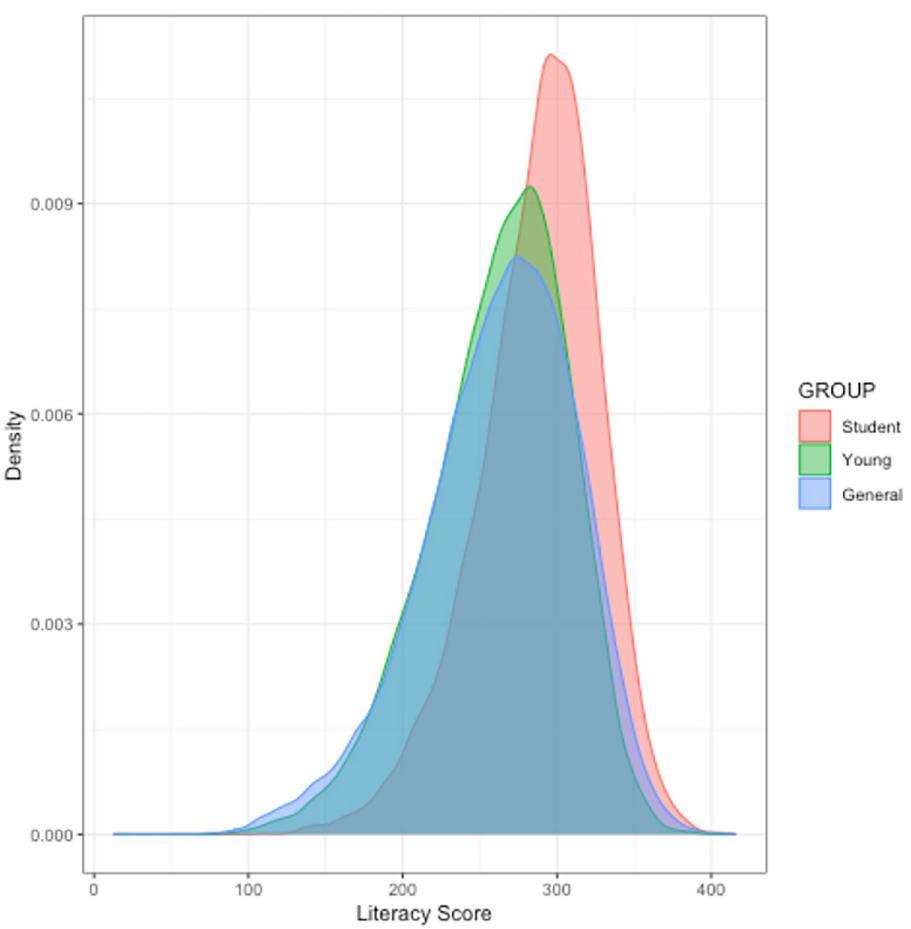
Fig 1. Distribution of literacy skills among the Student, Young and General samples of all countries. The red curve represents the Student sample, green represents the Young Sample, and blue represents the General sample.